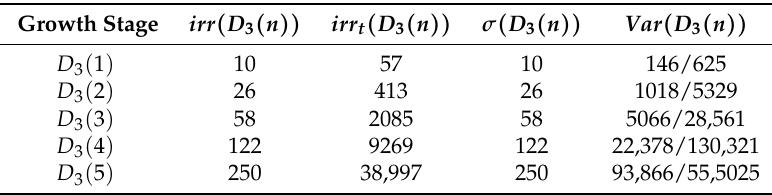
Table 3. The values of irregularity indices of structure of poly (propyl ether imine) (PETIM) dendrimers against different generation